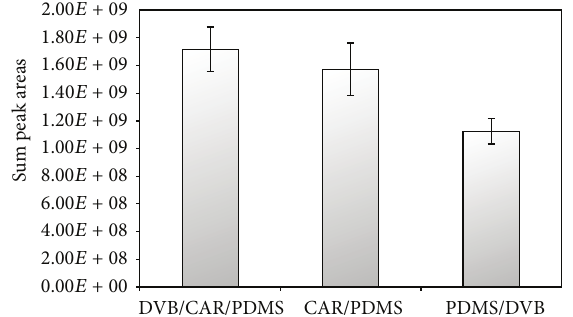
Figure 1: Comparison of different fiber coatings according to total peak